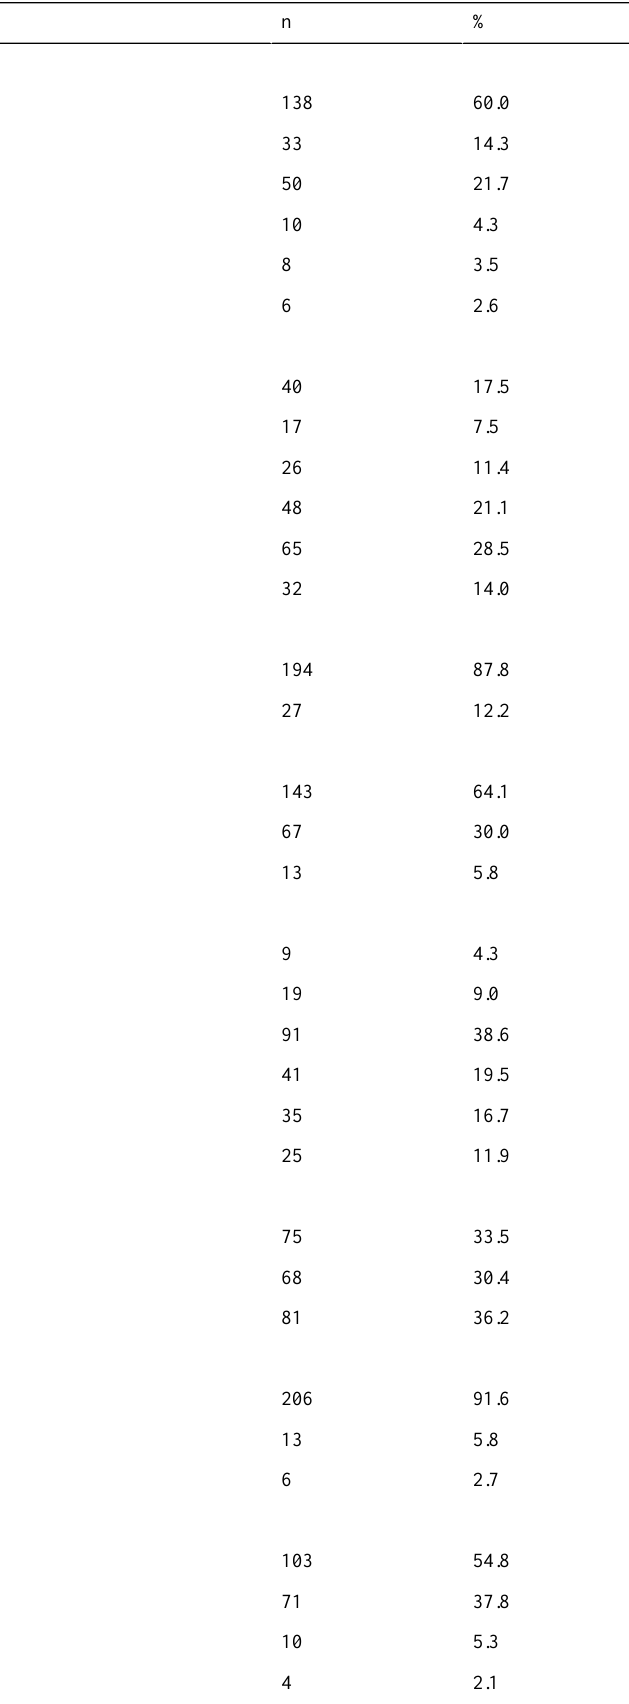
Table 2. Blogging-related behaviors of the survey participants (N =